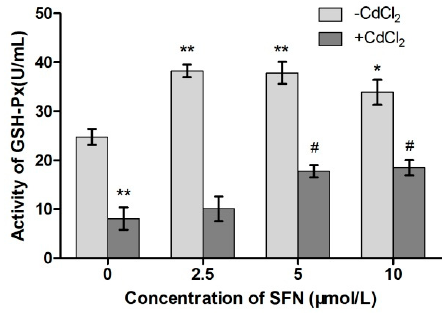
Figure 10. Activity of SOD in TM3. * represent a significant difference, respectively, compared with the control group. # represent a significant difference compared with the Cd group.